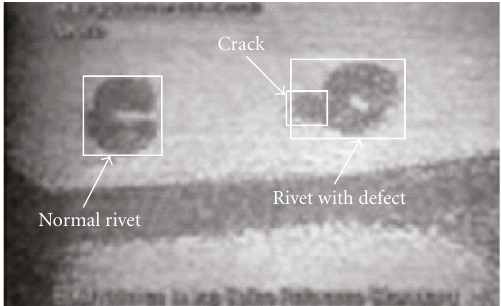
Figure 4: Sample MO image. On the left, a normal rivet with a circular shape; on the right, a rivet with crack in its